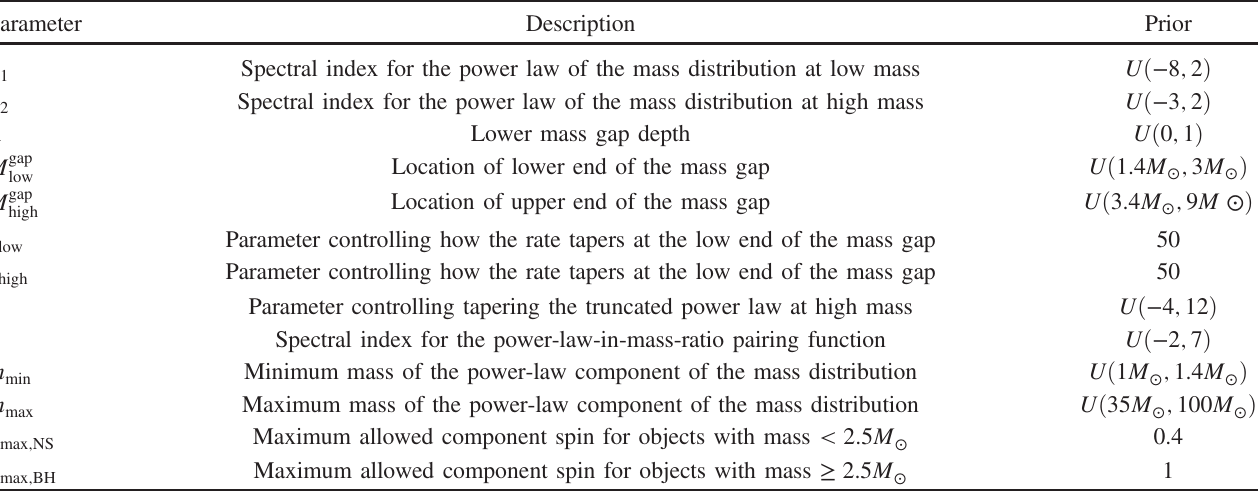
TABLE X. Summary of P OWER L AW + DIP +B REAK model parameters. The first entries describe the mass distribution parameters, and the last two entries describe the spin distribution parameters.